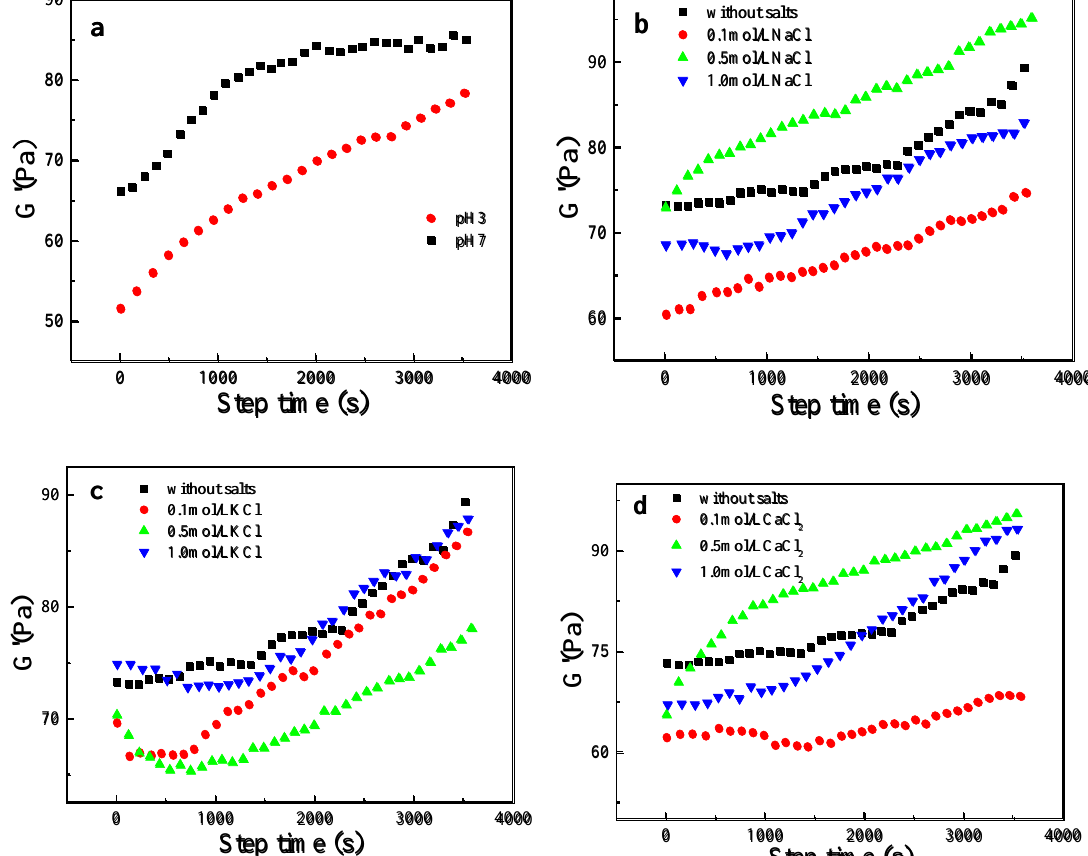
Figure 4. Curves of change in the storage modulus of LRS/KGM mixtures with time in acid or salt solutions. ( a ) acid (citric acid buffer); ( b ) NaCl; ( c ) KCl; ( d ) CaCl 2 .